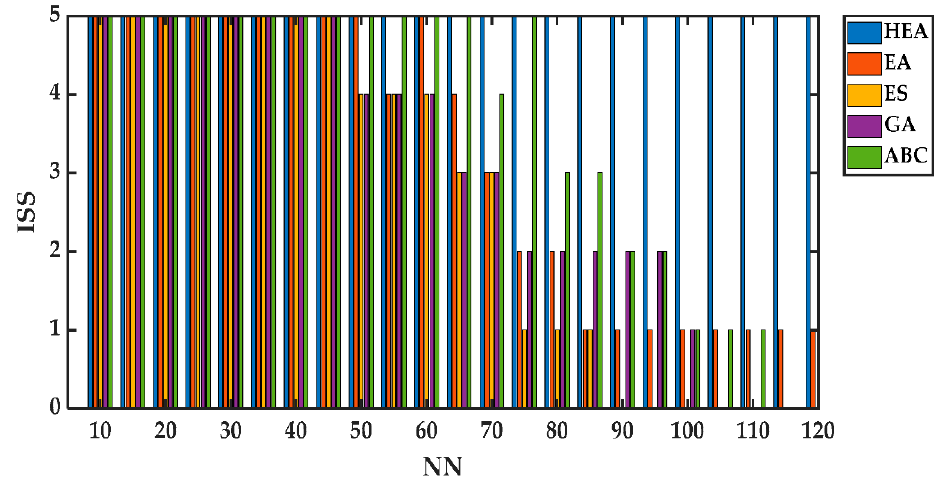
Figure 4. Number of Ideal Solution Strings (ISS) for different DHNN-RAN k SAT models.